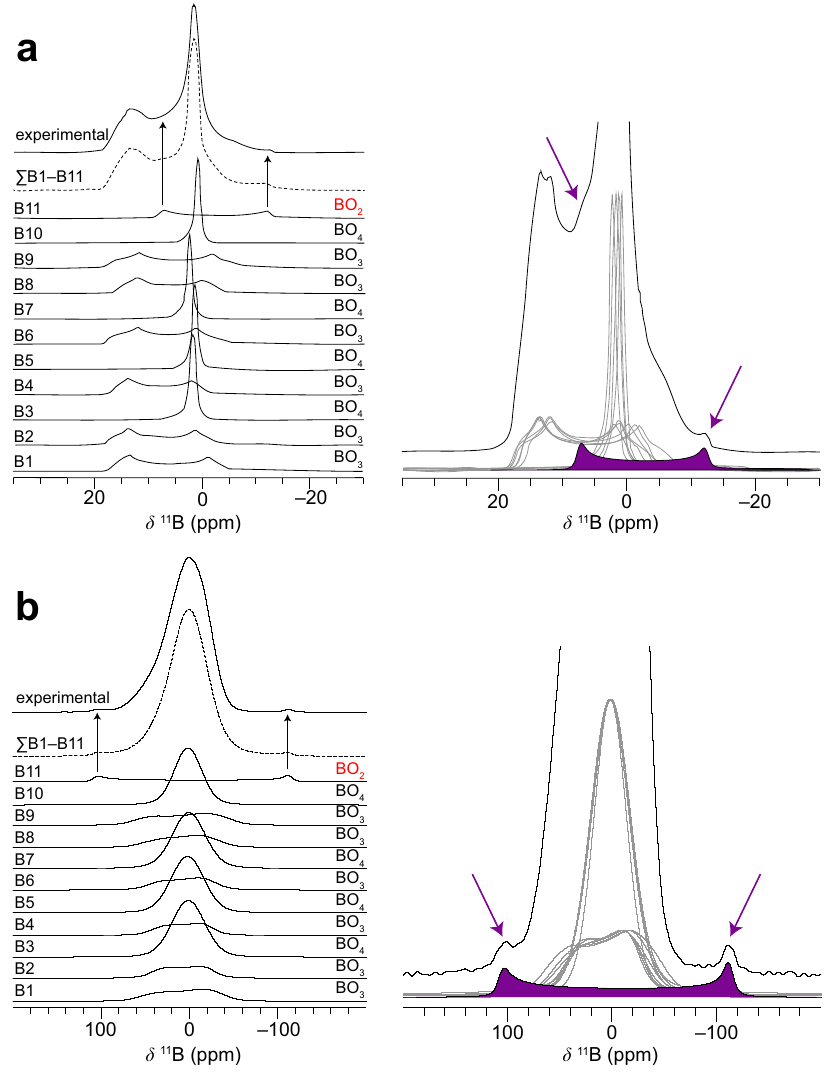
Fig. 2 Experimental and simulated 11 B NMR spectra. (Left) The experimental powder lineshape along with the 11 individual boron sites that comprise the summed simulation are shown for a 40 kHz magic-angle spinning and b static conditions. The shift and quadrupolar tensors are given in Supplementary Table 5. (Right) Highlighted spectral features of the linear BO 2 motif and its contribution to the overall lineshape of K 5 Ba 2 (B 10 O 17 ) 2 (BO 2